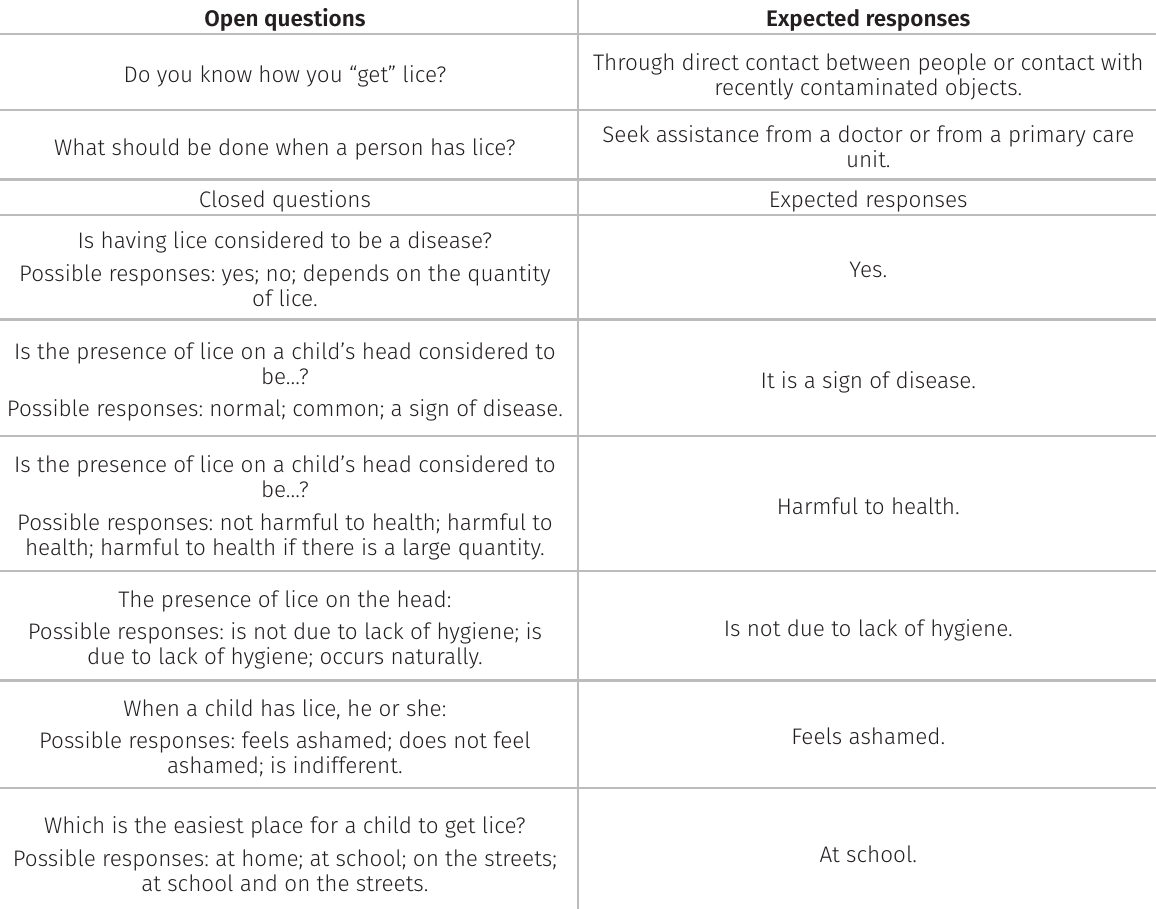
Table I. Expected responses for each question contained in the questionnaire on knowledge that was applied to the parents and guardians of children in years 1-4 of elementary school, in Niterói, RJ,